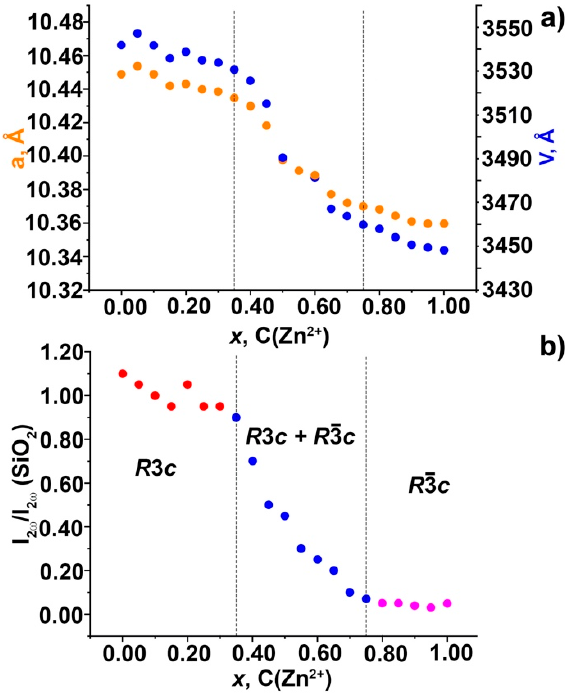
Figure 3. Dependence of unit cell parameters ( a ) and the second harmonic generation signal ( I 2 ω / I 2 ω (SiO 2 )) ( b ) on the Zn 2+ concentration for Ca 9 − x Zn x Gd(PO 4 ) 7 :0.1Eu 3+ solid